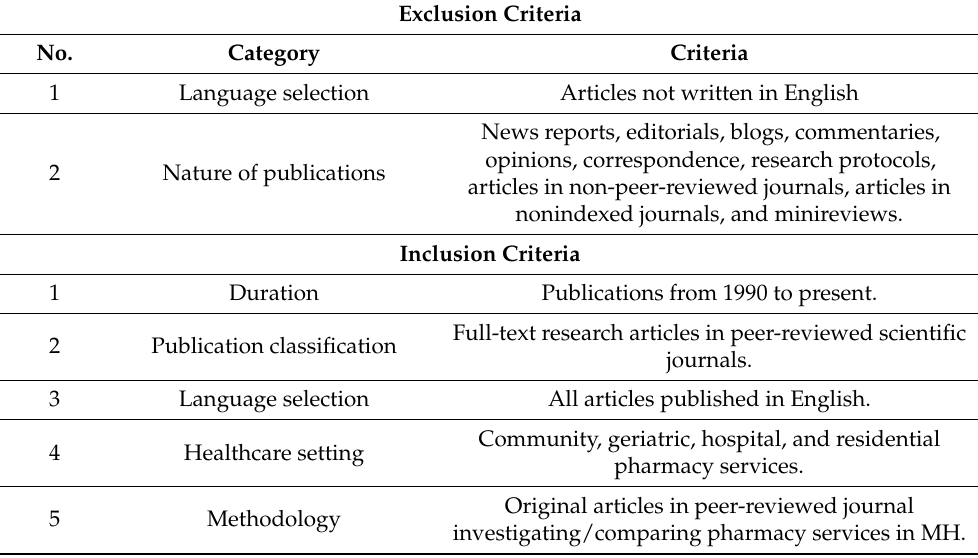
Table 1. Study exclusion and inclusion